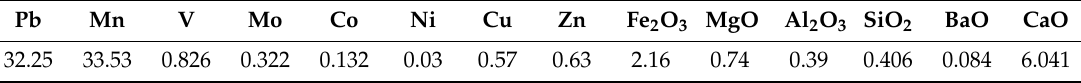
Table 7. Chemical analysis of coronadite product (wt%).